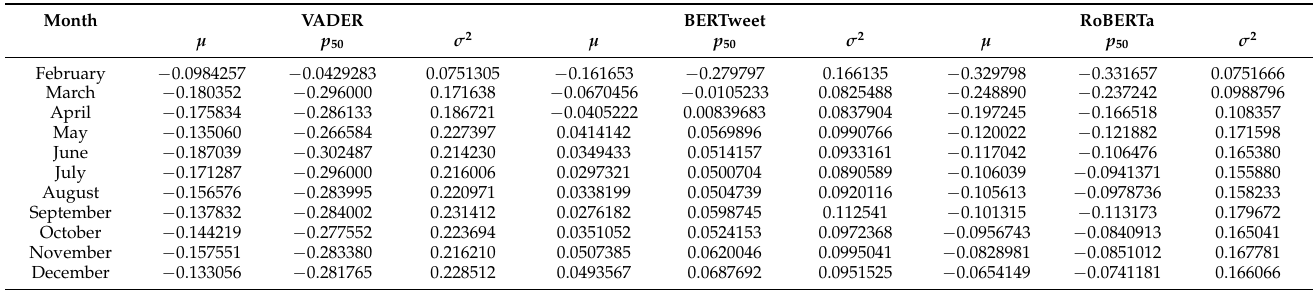
Table 3. Monthly summary statistics for the compound sentiment polarity in Mexico, utilizing several language models. Note that the polarity is expressed in the range ( − 1,1 ) .